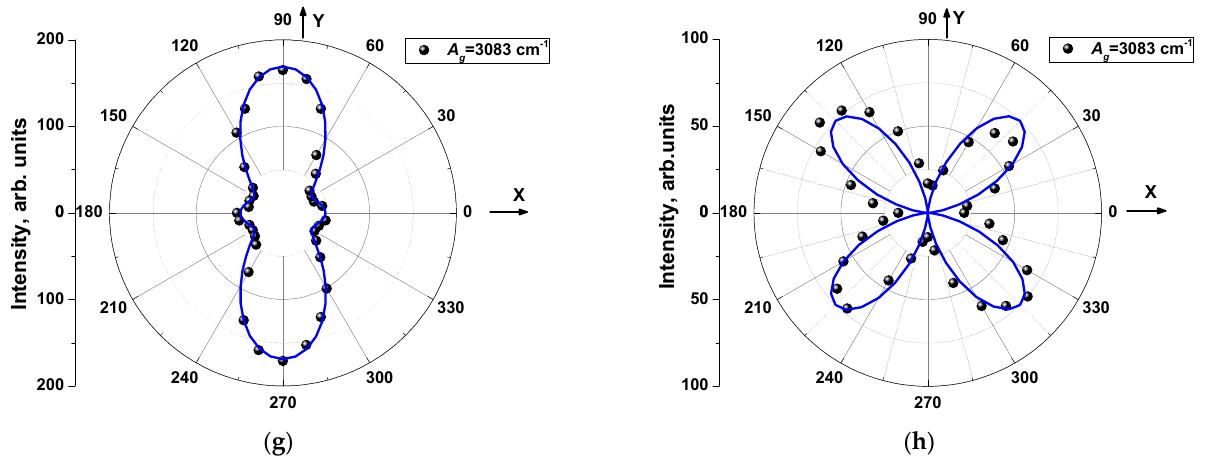
Figure 6. Angle variations of Raman intensity measured in PP ( a , c , e , g ) and CP ( b , d , f , h ) geometry for lines of Ag symmetry. Blue lines correspond to calculations using expressions (Table 5). ( a , b ) line